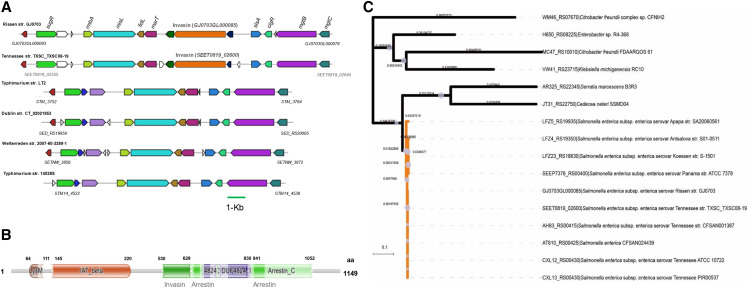
Comparative analysis of S. Rissen SPI-3. Schematic diagram of the genetic organization and invasin phylogeny of SPI-3. (A) An insertion fragment contains the invasion-associated genes. The SPI-3 homologs of S. Rissen were collinearly compared with the counterparts in the genomes of strains Typhimurium LT2, Dublin CT0202183, Tennessee TXSC_TXSC08-19 and Typhimurium 14028S. The genes of mosaic SPI-3 homologs identified in a variety of Salmonella genomes were color coordinated, and insertion genomic fragments were defined. (B) Conserved domains of this invasin predicted by Pfam (available at pfam.xfam.org, e-value ≤ 0.01). LysM: Lysin Motif, a protein domain found in a wide variety of extracellular proteins and receptors. IAT_beta: Inverse autotransporter beta-domain, a family of beta-barrel porin-like outer membrane proteins from enteropathogenic Gram-negative bacteria. DUF4824: the function of this family is unknown but DUF4824 is mainly found in Pseudomonas species. (C) Phylogenetic relationships of invasion homologs were inferred by using MEGA7 (available at megasoftware.net, NJ methods), and evolutionary distances and bootstrap values were denoted close to the phylogenetic clades. This gene was only found in Salmonella enterica serovar Tennessee strains and their closely-related isolates. Homologs of this invasin were predicted by BLASTp-based searches (threshold: identity ≥ 40%, e-value ≤ 0.01).